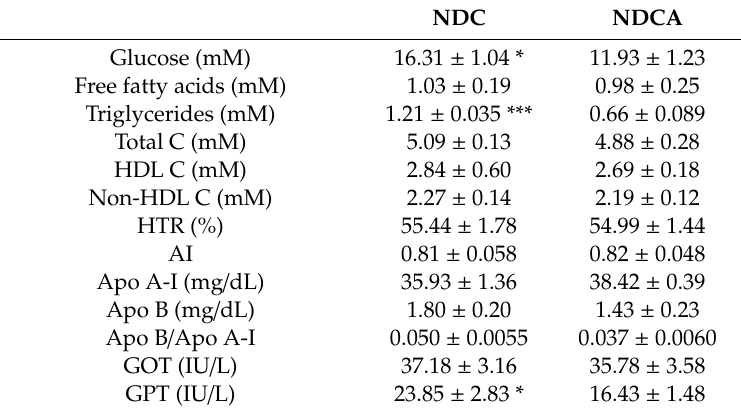
Data are mean ± SE. Significant differences between the 5% D-allulose group and without D-allulose group are indicated; * p < 0.05, ** p < 0.01, *** p < 0.001. NDCA, high-fat diet with non-dairy creamer + 5% D-allulose; NDC, high-fat diet with non-dairy creamer. HDL, high-density lipoprotein cholesterol; HTR, (HDL cholesterol / total cholesterol) × 100; AI, atherogenic index, [(total cholesterol) − (HDL cholesterol)] / HDL cholesterol; Apo A-I, apolipoprotein A-I; Apo B, apolipoprotein B; GOT, glutamic oxaloacetic transaminase; GPT, glutamate pyruvate